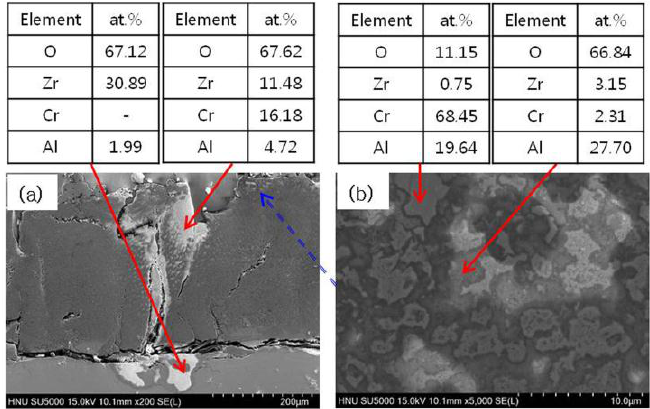
Figure 6. SEM micrographs with EDS profiles of the oxidized CrAl coating layer on Zircaloy-4 after isothermal heating at 1100 °C for 10 min in air.